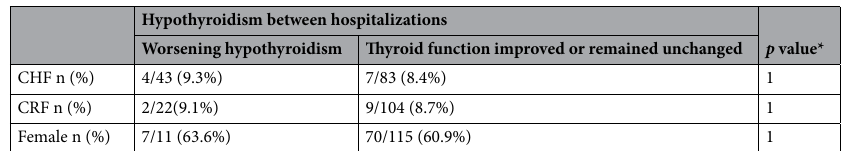
Hypothyroidism between hospitalizations